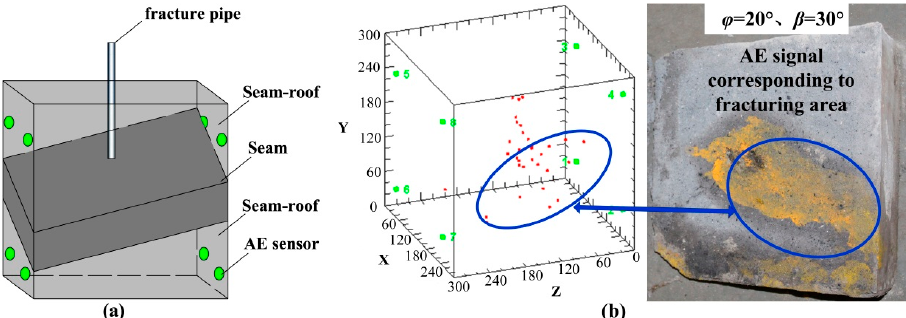
Figure 9. Location of acoustic emission (AE) sensors on the HF test sample ( a ) and block diagrams ( b ) showing AE ‐ recorded event sites and a photograph of a fracture surface in the tested specimen. A tracer was introduced into the fracturing fluid and the presence of the tracer material (light brown in the photograph) on the fracture surface verifies that the AE events recorded the fracture initiation sites and fracture shape well.